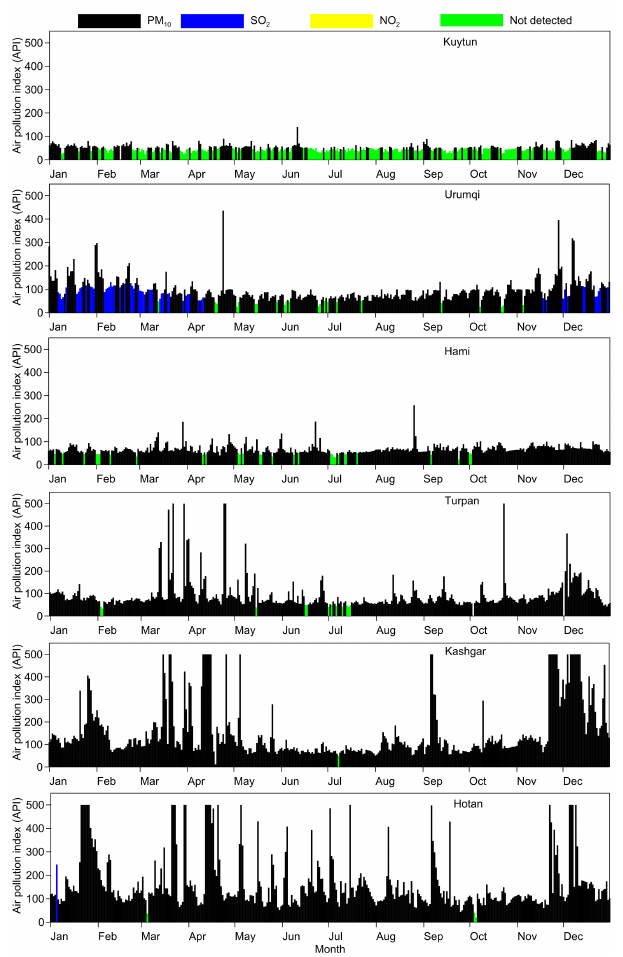
Figure 8. Daily air pollution index for Kuytun and Urumqi in north- ern Xinjiang, Hami and Turpan in eastern Xinjiang, and Kashgar and Hotan in southern Xinjiang in 2010. The main air pollutant contributing to the daily API is identified for each station. “Not de- tected” indicates excellent air quality (API<50).